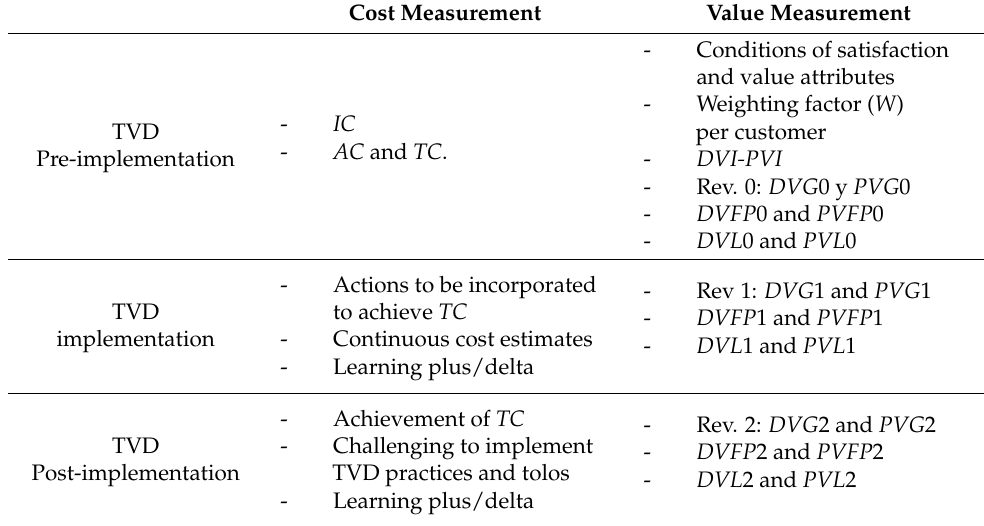
Table 4. Data collection for